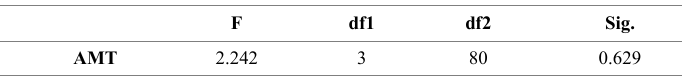
Table 8. Result of Variety Homogeneity Test.